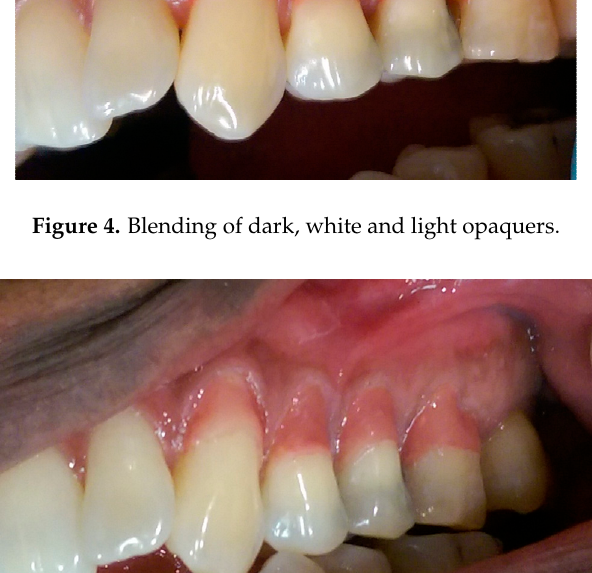
Figure 5. Opaquer placement for characterization of gingiva.